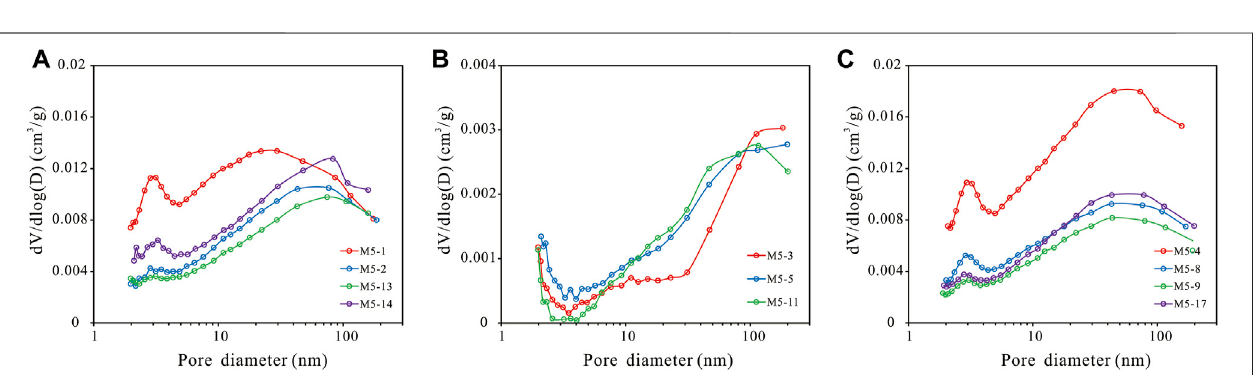
FIGURE 7 | Nitrogen adsorption pore size distribution curves of different samples. (A) Shale; (B) Coal; (C) Tight sandstone.